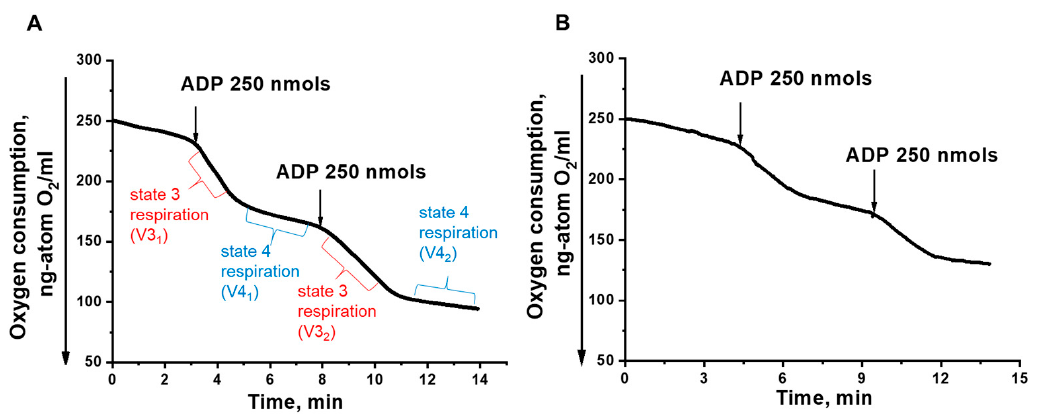
control cells (Figure 4B).